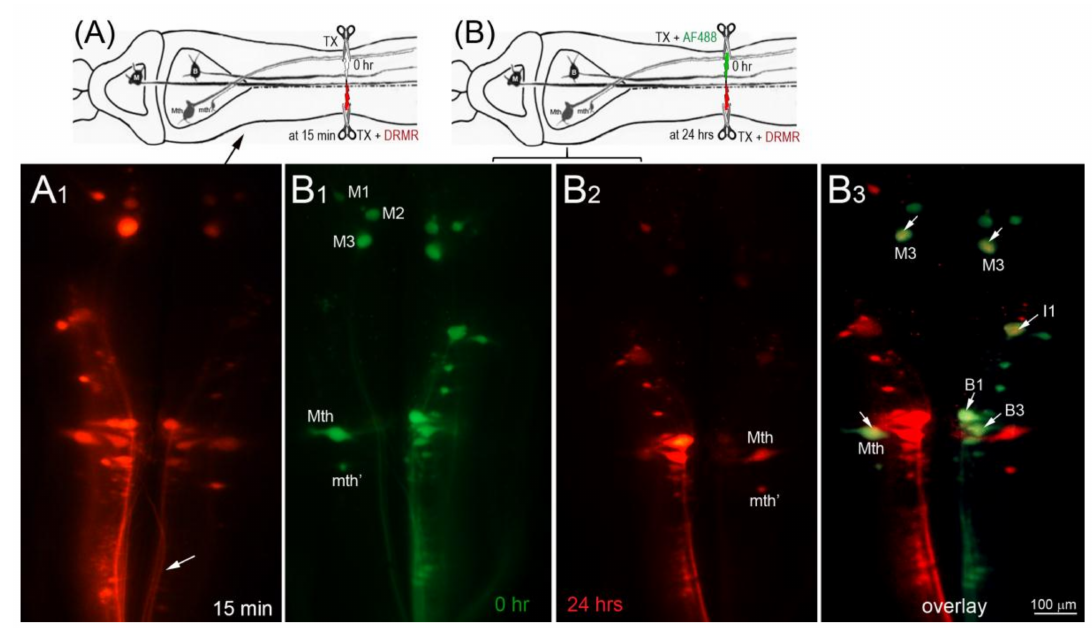
Figure 3. Most damaged axons of large RS neurons failed to seal completely at 24 h after spinal cord TX. In this figure, drawing ( A ) diagrams the experiment in micrograph ( A1 ), and drawing ( B ) diagrams the experiments in micrographs ( B1 – B3 ). ( A ) A right hemi-TX was made at the level of the 5th gill. The TX was completed 15 min later with a left hemi-TX, and DTMR (red) was applied to the TX site. The small non-identified neurons of the left medial-inferior RS neurons are unlabeled (white arrows), indicating that their axons have sealed; ( B ) D-AF488 (green) was applied to a fresh right hemi-TX at the 5th gill ( B1 ). (Note, the left M 1 , M 2 , and M 3 neurons are unintentionally labeled because their axons are located very near the midline in the spinal cord); at 24 h post-TX ( B2 ), DTMR was applied to a fresh left hemi-TX at the same level. RS neurons not labeled with D-AF488 in ( B1 ) were strongly labeled with DTMR, but some large RS neurons labeled with D-AF488 were also lightly labeled with DTMR (white arrows in overlay image of ( B3 ), indicating that their axons were not completely sealed by 24 h post-TX. These neurons are bad